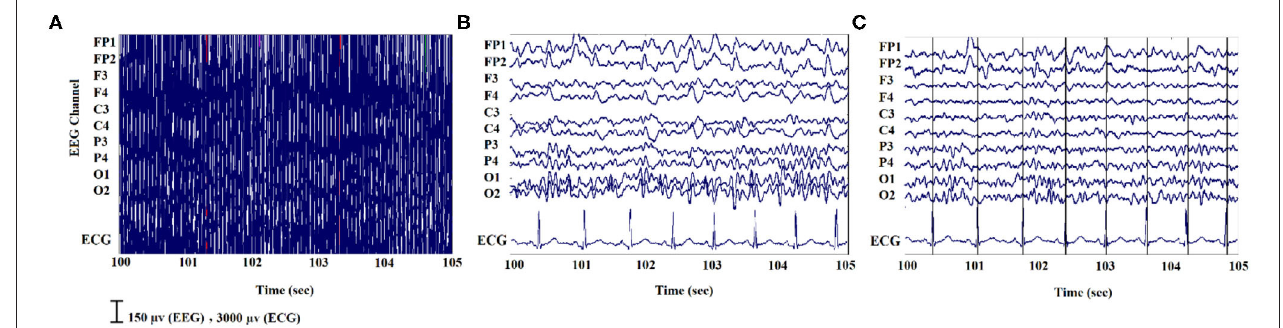
FIGURE 2 | An illustration of EEG signals recorded inside the scanner: (A) noisy signal; (B) after removing the MR gradient artifact; (C) after eliminating the BCG